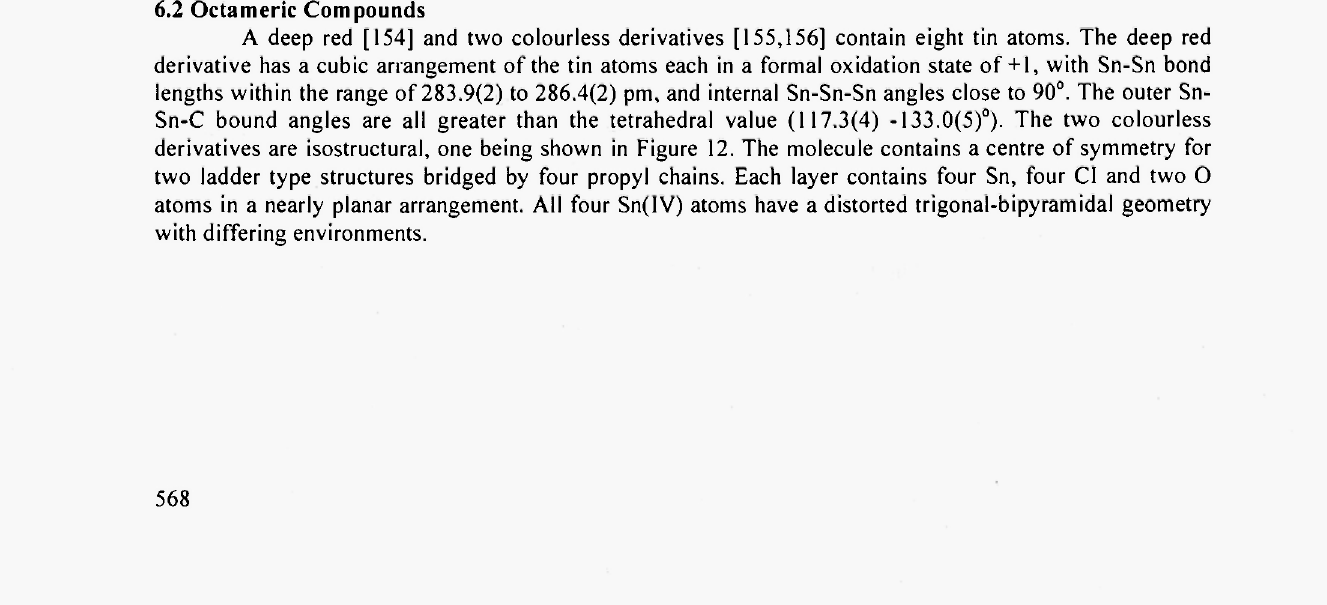
Fig. 11. View of the Sn 7 S 6 0 2 double cube